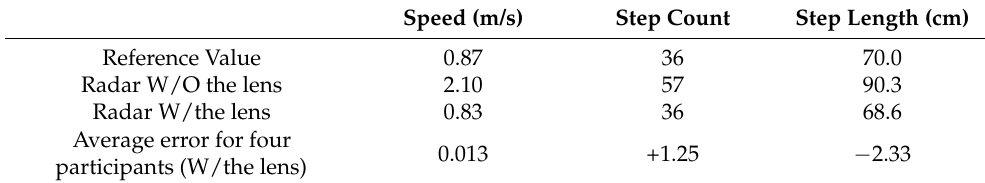
Figure 8. Peak detection algorithm applied to the absolute value of the velocity of the torso using the radar sensor integrated with the in-package lens. Table 2. Extracted gait values in a